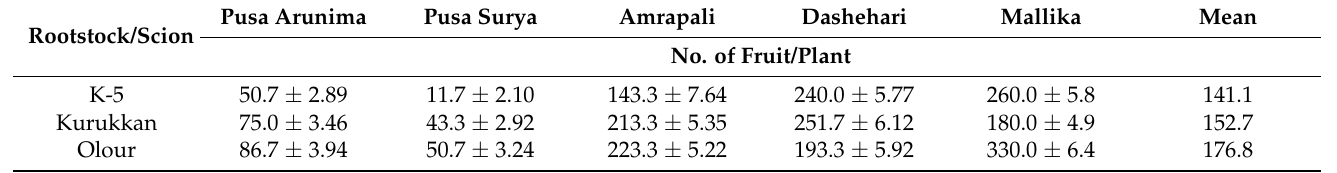
Table 1. Influence of rootstock, scion, and their interaction on fruit yield of scion/rootstock combina- tions of